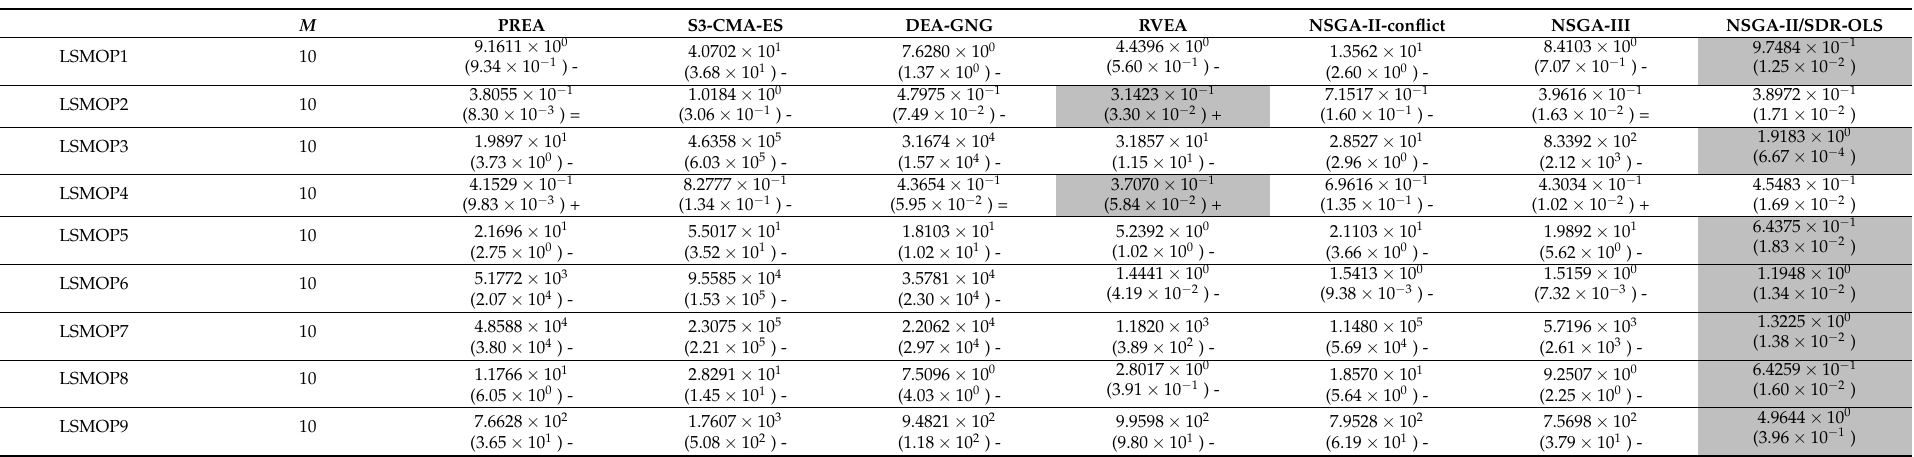
Table 12. IGD values for 9 ten-objective benchmark problems.